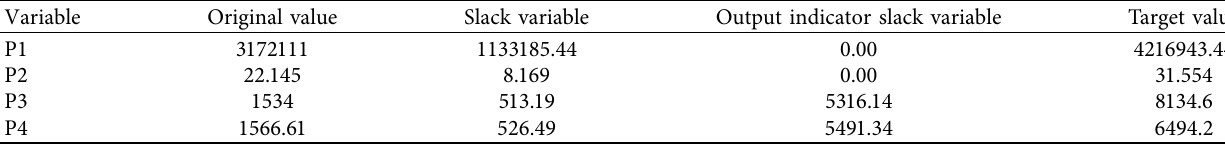
Table 3: Projection summary results of sample 5.